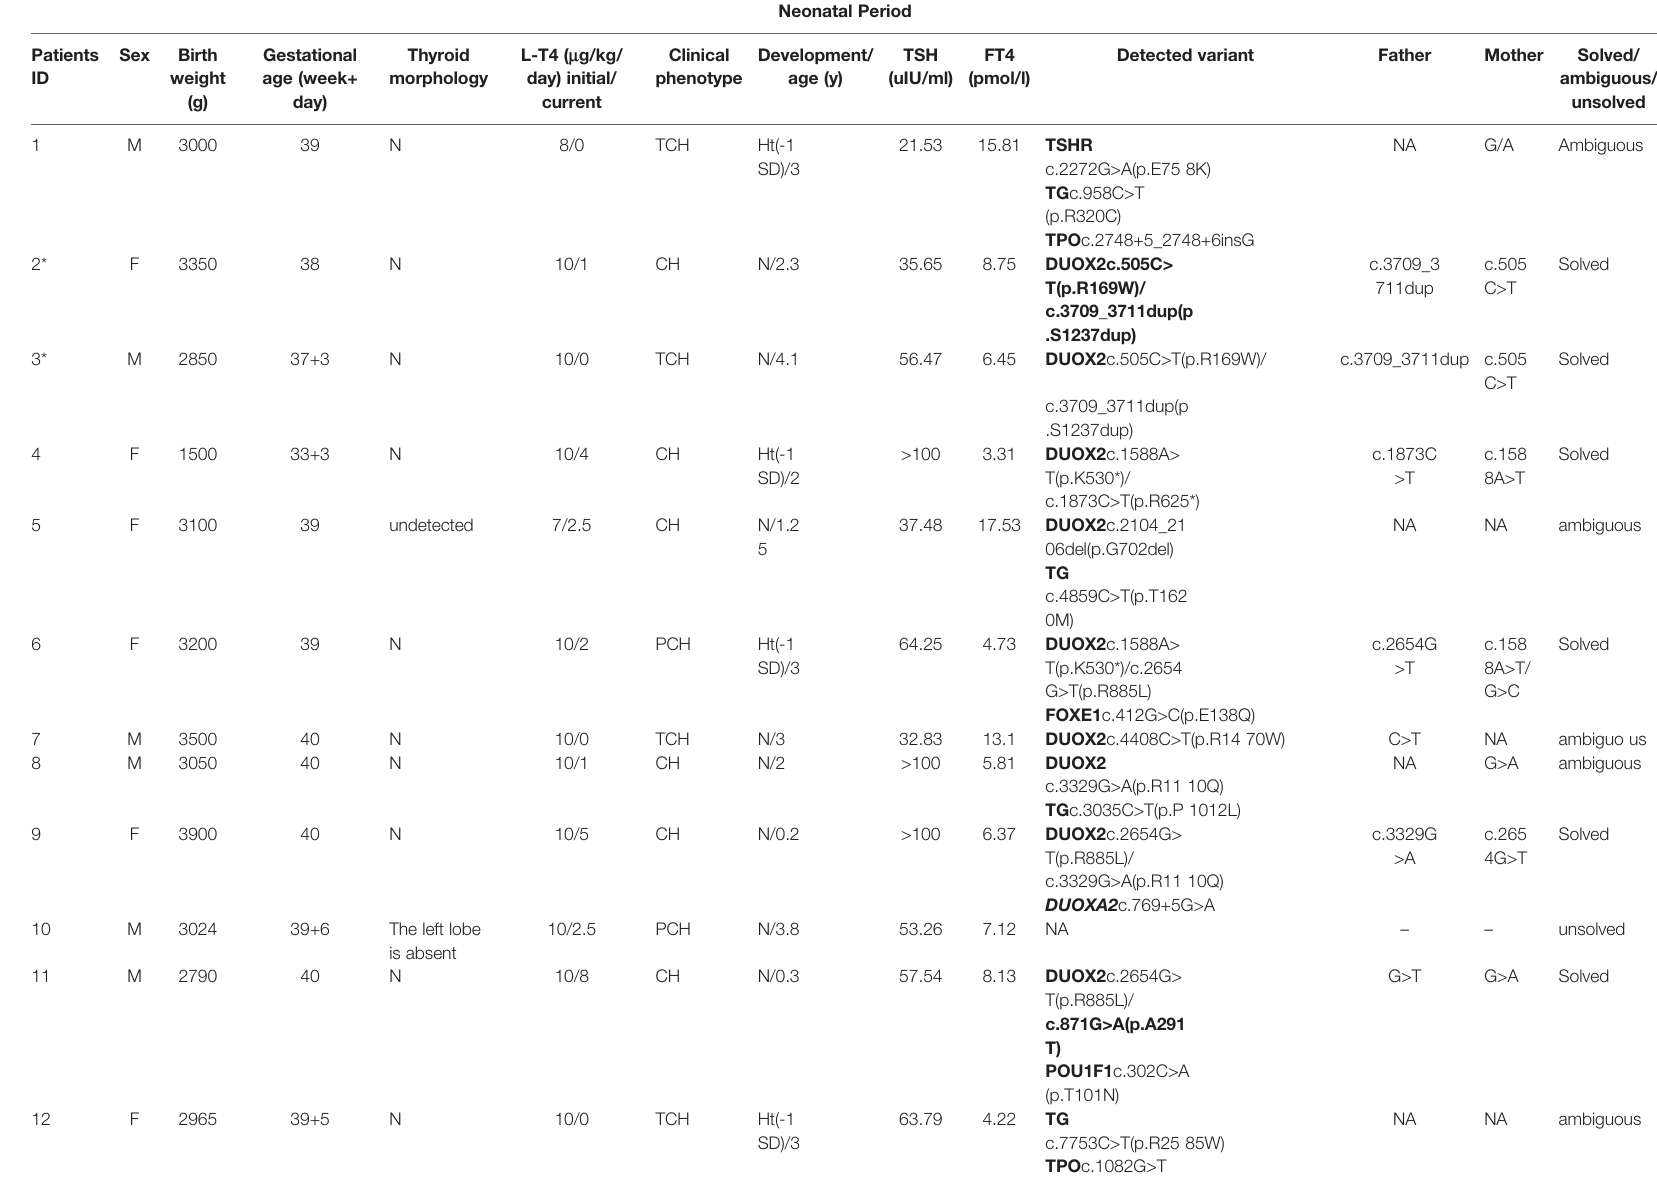
TABLE 1 | Clinical Information, detected variants, and results of family segregation analysis of studied patients with